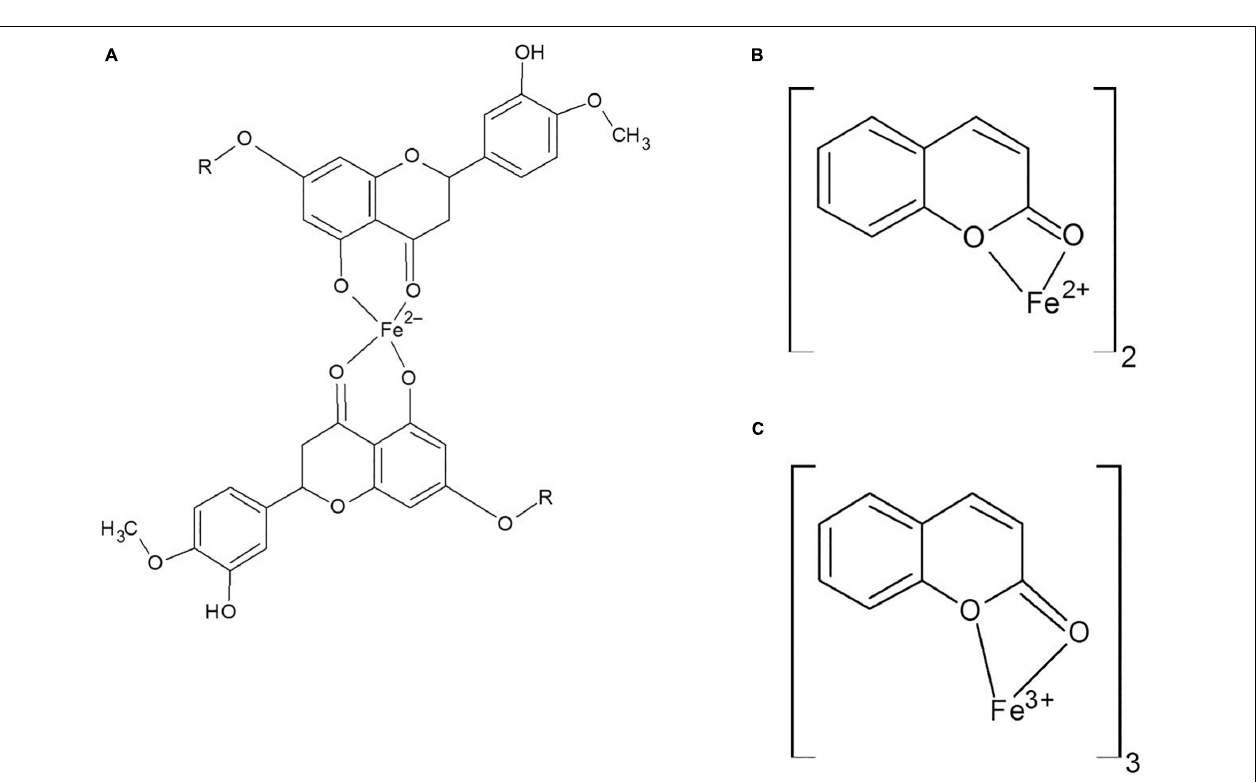
FIGURE 7 | Brain tissue perl’s staining in the treatment mice. (A) Control group: Normal saline-receiving group. (B) Normal saline and deferoxamine-receiving group. (C) Iron dextran and normal saline-receiving group. (D) Iron dextran and deferoxamine-receiving group. (E) Low dose hesperidin-receiving group. (F) High dose hesperidin-receiving group. (G) Low dose coumarin-receiving group. (H) High dose coumarin-receiving group.